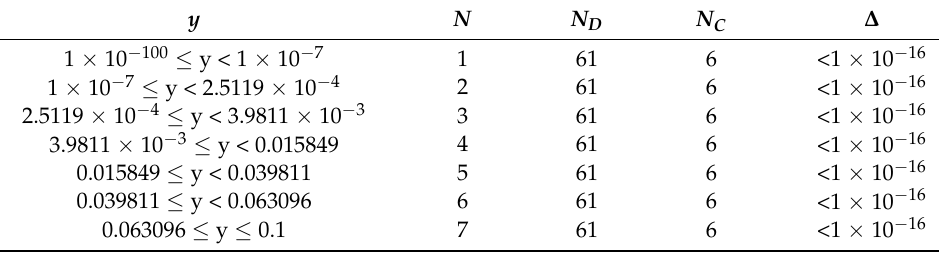
Table 3. The optimal parameters N , N D , and N C with accuracy levels ∆ = 1 × 10 − 16 . y N N D N